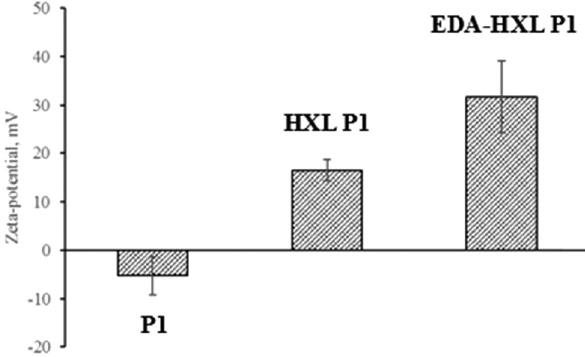
Figure 2: Zeta - potential of P1, HXL P1, and EDA - HXL P1 terpolymers, VBC ) ( EDA - HXL P1 ) terpolymer samples are shown in Figure 2. The zeta potential of EDA - HXL P1 ( 31.7 mV ) was